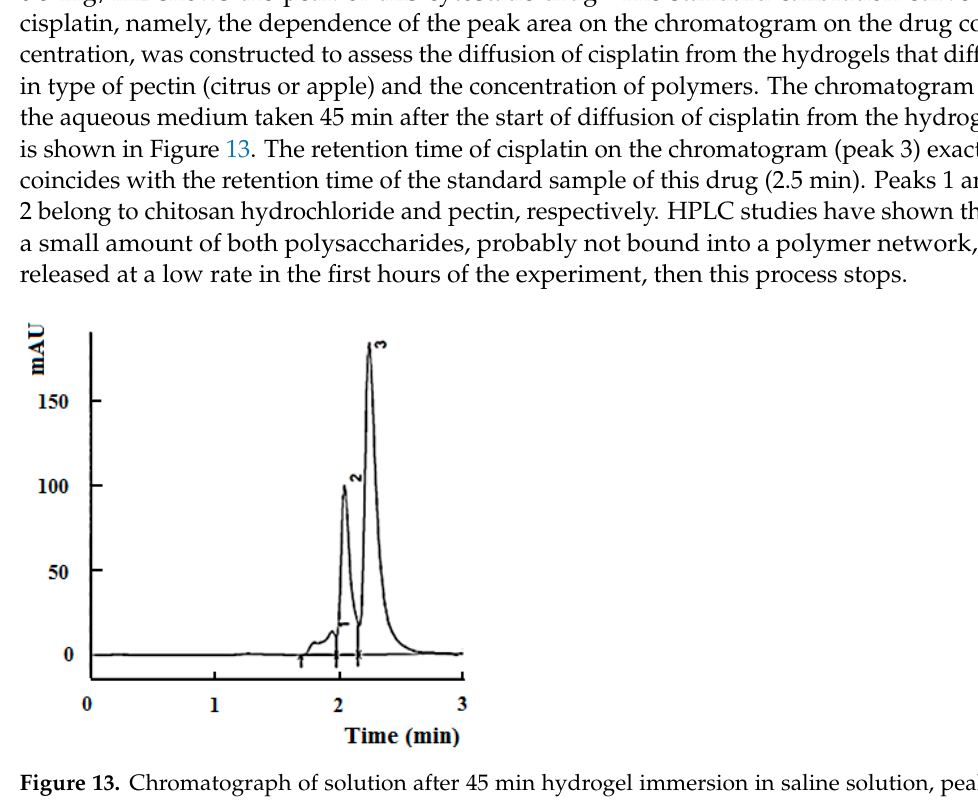
Figure 12. Hydrogel degradation by hyaluronidase 64 U/mL in saline solution at T = 20 ◦ C (1) or 40 ◦ C (2). Data are expressed as mean ± SD; n = 3.